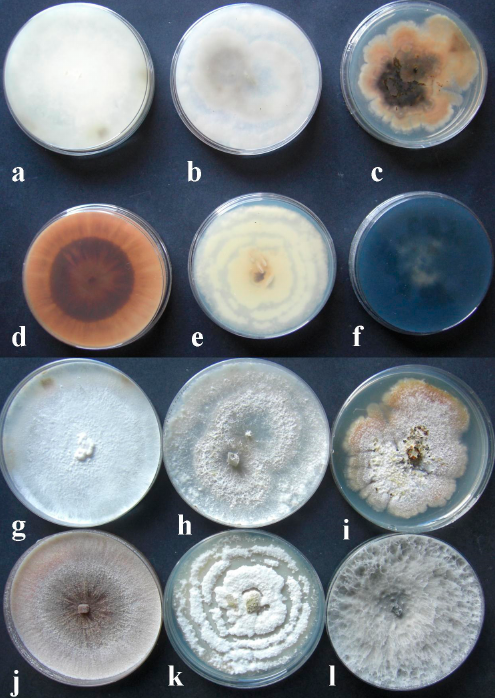
Figure 1. Pure fungal cultures on PDA obtained from samples of apples with dieback symptoms. ( a , g ) = Trametes versicolor ; ( b , h ) = Diaporthe eres ; ( c , i ) = Diaporthe feoniculina ; ( d , j ) = Pestalotiopsis fu- nerea; ( e , k ) = Phomopsis spp.; ( f , l ) = Neofusicoccum